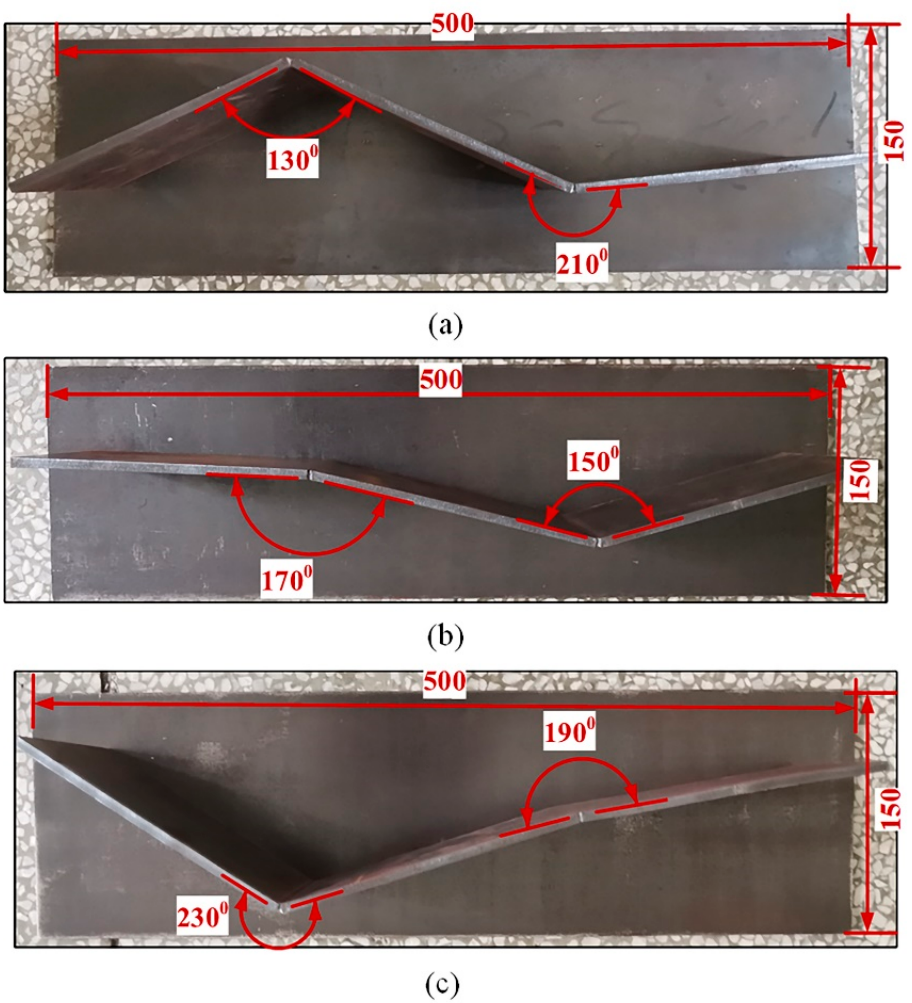
Figure 11. 3D zigzag-line welding seam workpieces; ( a ) 3D zigzag-line welding seams with fold angles of 130°and 210°; ( b ) 3D zigzag-line welding seams with fold angles of 170°and 150°; ( c ) 3D zigzag-line welding seams with fold angles of 230°and 190°.